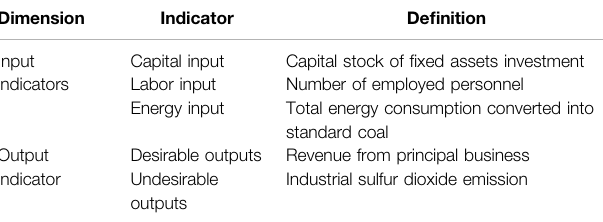
TABLE 1 | Input and output indicators de fi nitions. Dimension